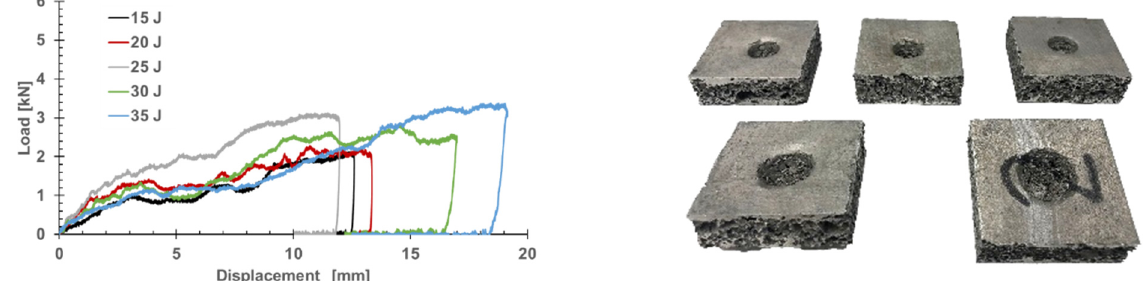
Figure 3. Load-displacement curves ( a ) and damaged AF panels ( b ) with thickness t ≈ 20 mm.